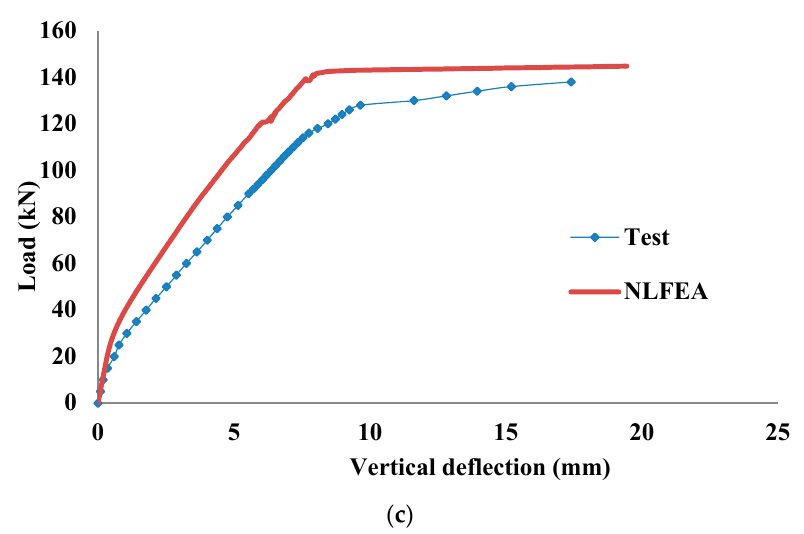
Figure 18. Comparison of load-vertical deflection responses: ( a ) Test model coded as S-Con; ( b ) Test model coded as S-C-2-9; ( c ) Test model coded as S-C-1-9.